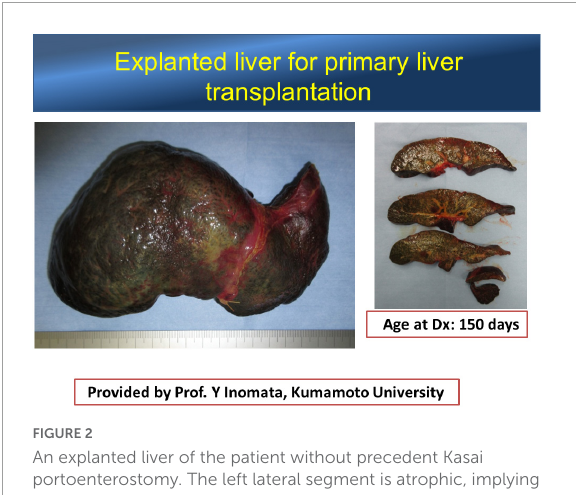
FIGURE2 An explanted liver of the patient without precedent Kasai portoenterostomy. The left lateral segment is atrophic, implying that atrophy is not because of the insufficient bile drainage. Courtesy of Dr. Yukihiro Inomata, Kumamoto